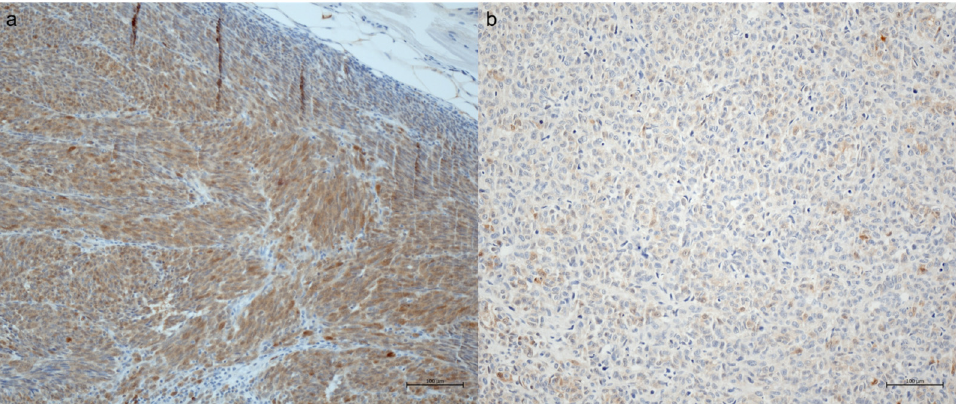
Figure 1. S100 stains of metastases, ( a ) with strong expression (H-score 3), scale bar: 100 µ m; ( b ) weak expression (H-score 1), scale bar: 100 µ